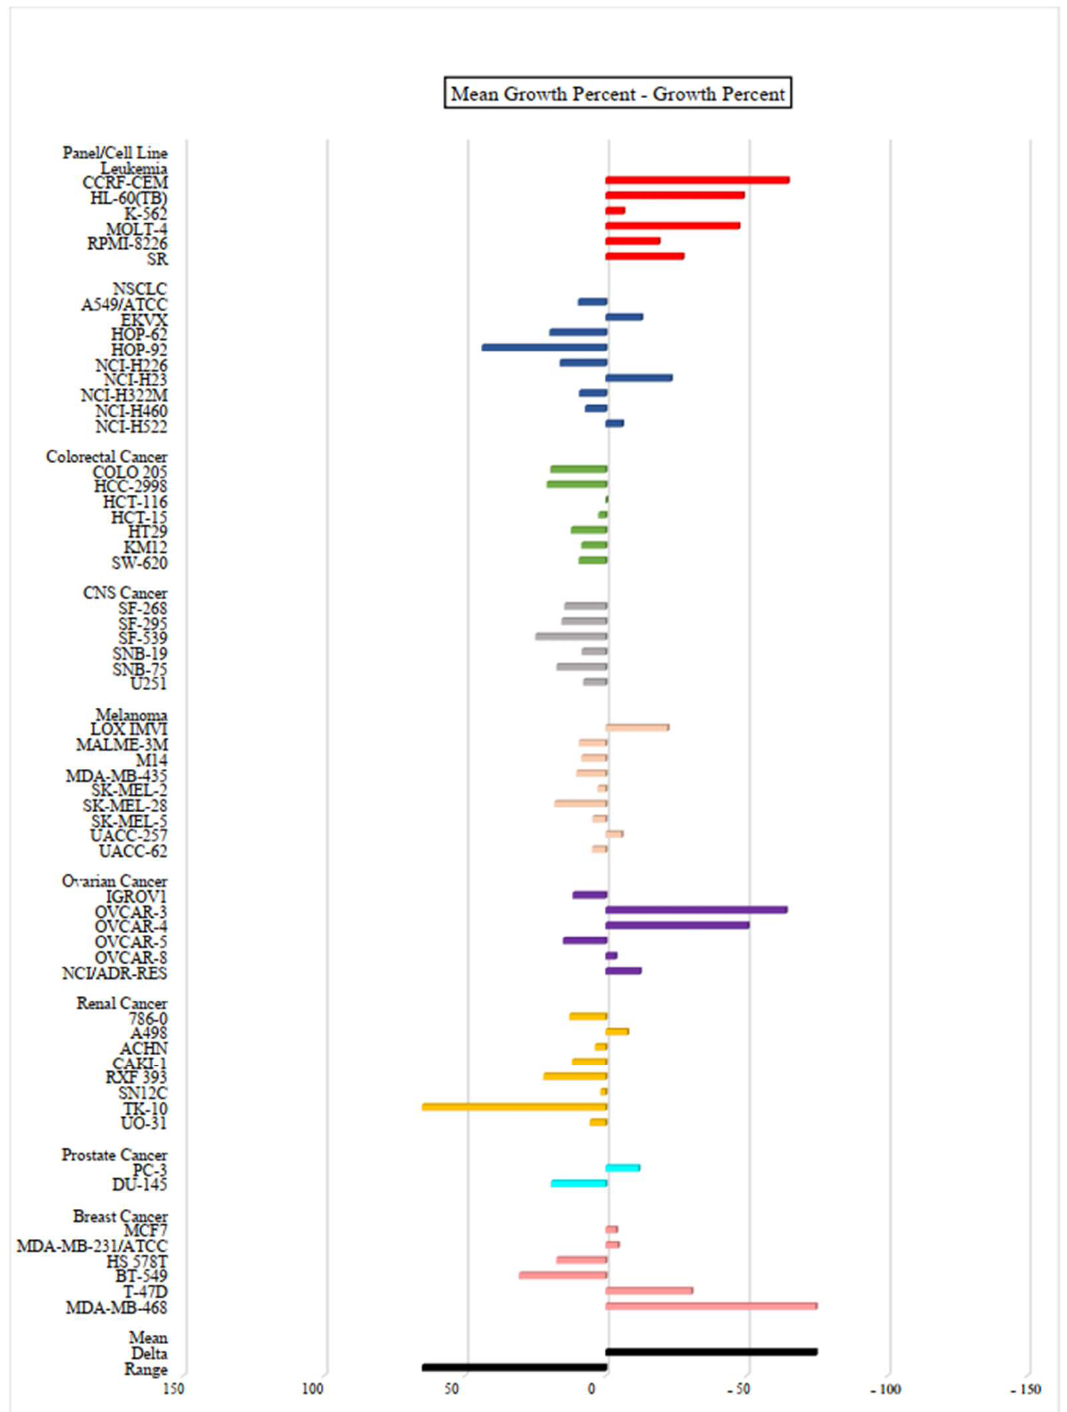
Figure 7. One-dose (10 μM) mean graph of PQ10 against different cancer cell lines. All experiments were repeated one time.